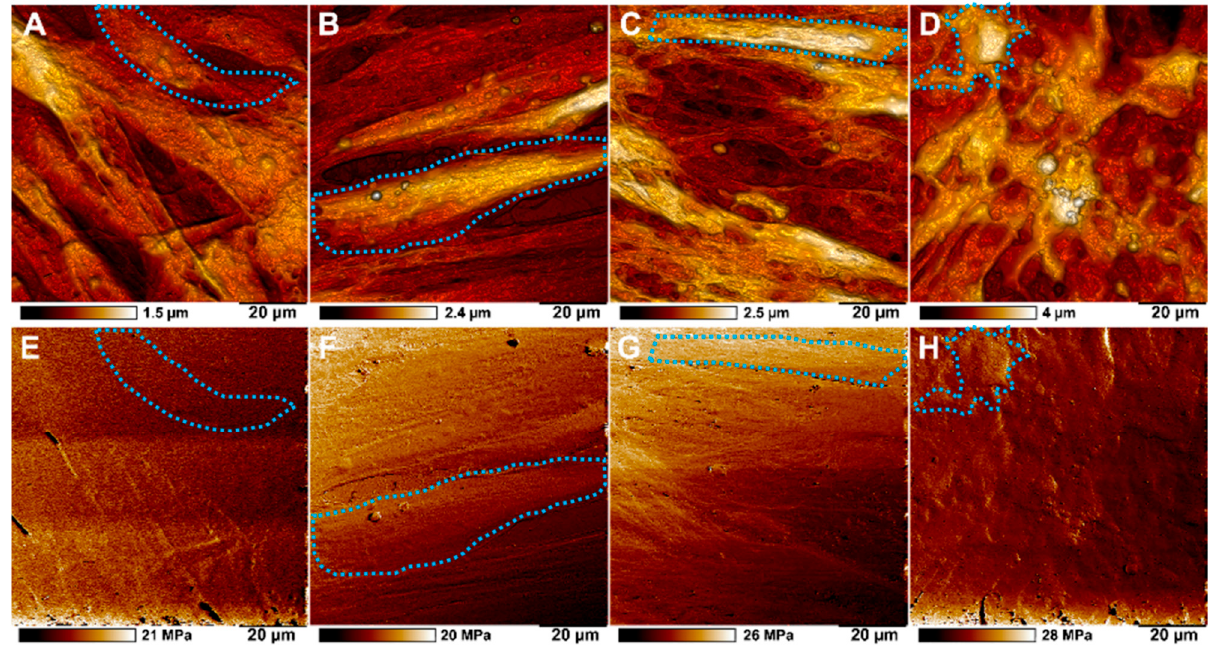
Figure 5. AFM imaging of topography (upper row) and adhesion (lower row) of MSCs during osteogenic differentiation on biopolymer scaffolds. ( A , E )—MSCs grown on control scaffold without HNTs in α -MEM, ( B , F )—MSCs grown on scaffold with pristine HNTs in α -MEM; ( C , G )—MSCs grown on control scaffold with pristine HNTs under osteogenic conditions, ( D , H )—MSCs grown on scaffold with forskolin-loaded HNTs in α -MEM. Single cells are marked with blue dotted line.